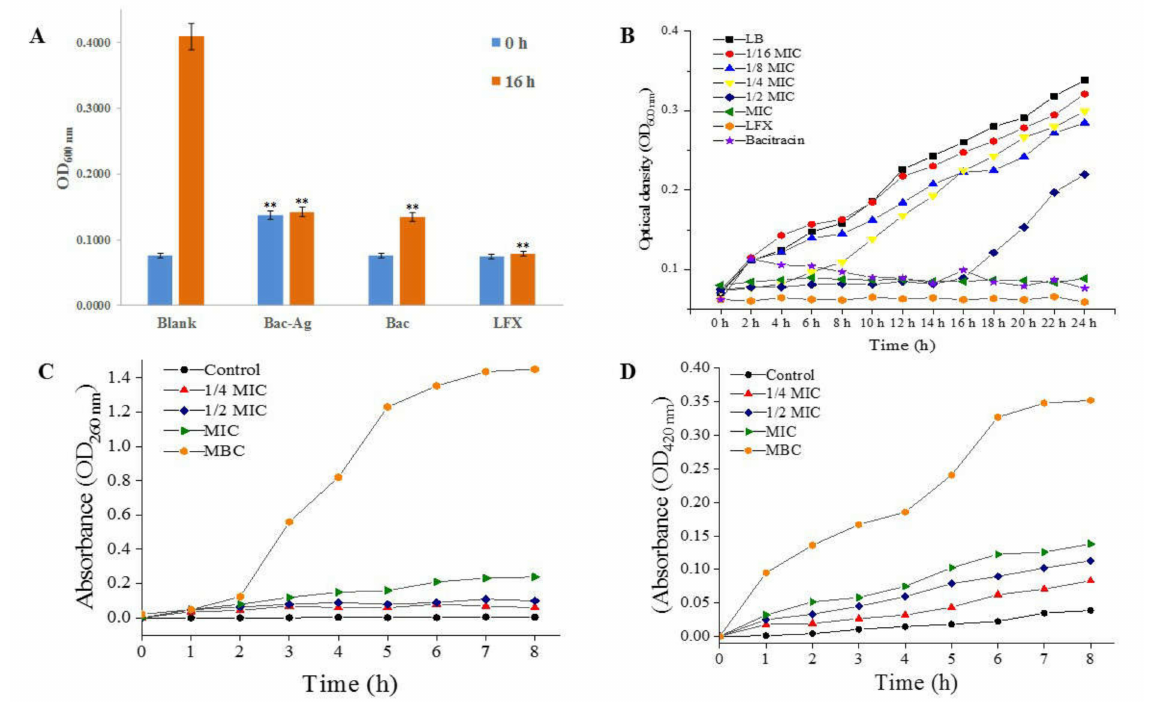
Figure 4. ( A ) Optical density at 600 nm (OD 600nm ) of bacteria in turbidity test. ( B ) The growth curves of S. flexneri treated with Bacitracin-AgNCs. ( C ) Effect of Bacitracin-AgNCs on nucleotide release and ( D ) cell membrane permeability of S. flexneri . ** Statistically significant differences ( p < 0.05).